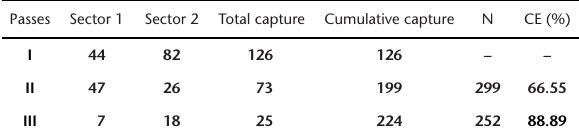
Table 1. Total number of captured individuals, cumulative capture, estimated total number of individuals (N) and capture efficiency (CE) for each sector of the pool by each pass.